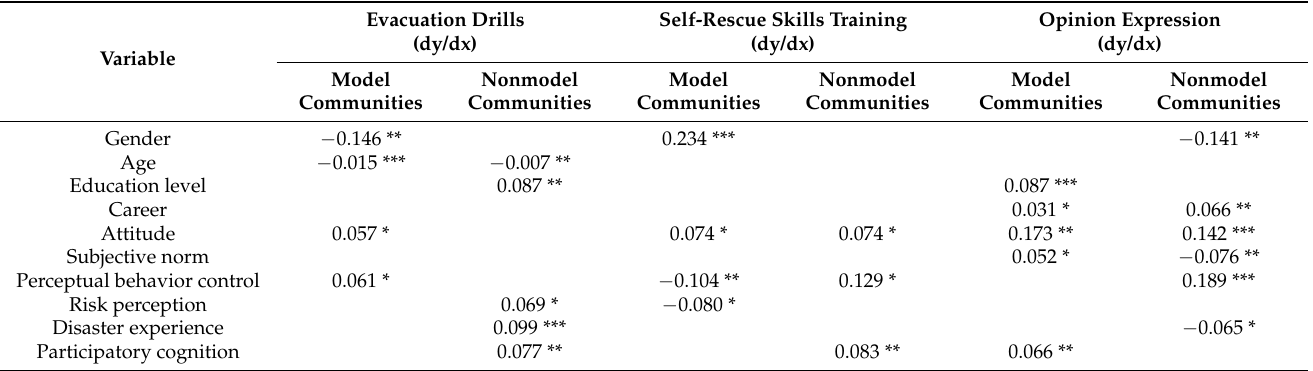
Table 5. Binary logistic regression marginal effect